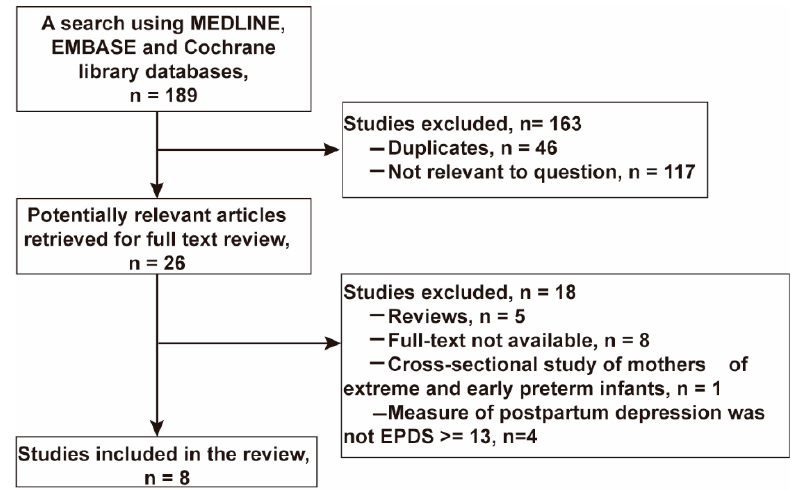
Figure 1. Study selection flow diagram.